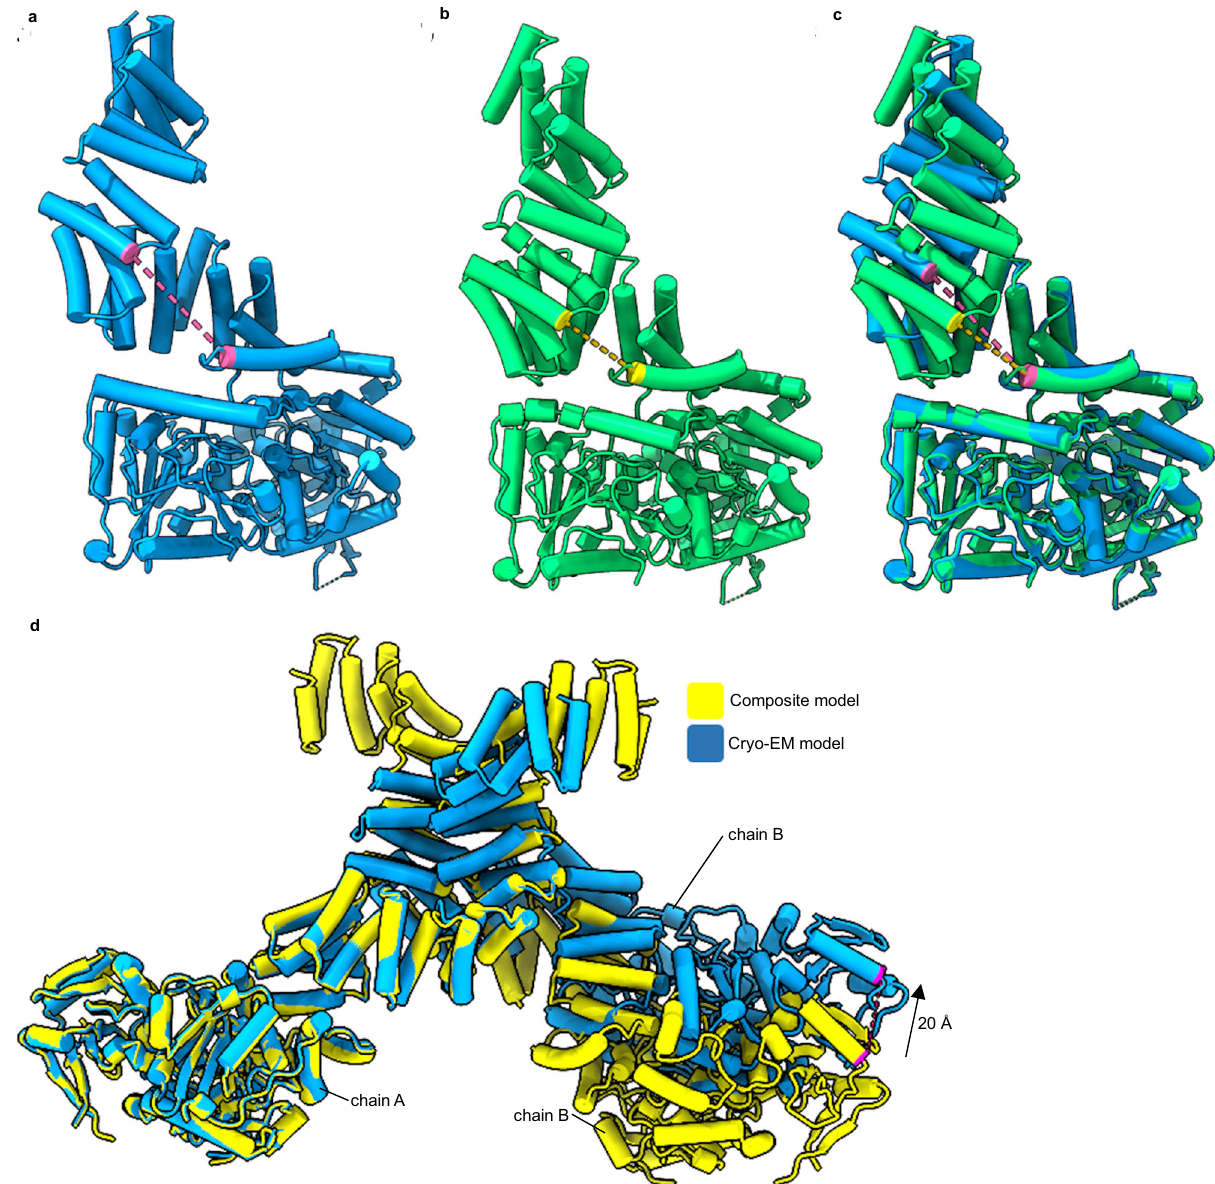
Fig. 5 Deviations from proposed full-length models of OGTs. a Cryo-EM model of OGT with the measured distance between V229 C α to E488 C α depicted as a pink dashed line. b Crystal structure composite model of OGT generated by superimposition of residues 313 – 400 of 11.5 TPR chain A (PDB: 1W3B) onto the OGT/UDP structure (PDB: 3PE3) 13, 14 . Distance between V299 C α to E488 C α depicted as a yellow dashed line, calculated as 25 Å for a and 18 Å for b . c Superimposition of residues 544 – 1028 of the Cryo-EM model onto the speculated model. A large face is opened in our structure compared to the composite structure. d Superimposition of chain A of the L254F composite model onto chain A of our cryo-EM structure 24 . Composite model was generated by superimposing our catalytic domain, with the correct TPR 10 position, onto the 11.5 TPR L254F mutant dimer crystal structure (PDB: 6EOU) using residues 260 – 360 24 . A movement of 20 Å would be required in chain B for equivalent T771 C α atoms to Expression and His-tag puri fi cation steps were as described above except only 2 l of TB was required for each mutant. Instead of dialysis, protein was diluted to 50 mM NaCl with 20 mM HEPES 7.5 and loaded onto a 5ml Q Sepharose FF column pre- equilibrated in buffer C (25 mM HEPES 7.5, 50 mM NaCl and 1 mM DTT). Protein was eluted by a stepwise gradient of buffer D (25 mM HEPES 7.5, 1M NaCl and 1mM DTT) in buffer C. Fractions containing pure protein were pooled and concentrated to 2 ml using 10,000 MWCO Vivaspin ® spin-concentrators (Sartorius), before being size excluded on a 16/60 Superdex 200 column (GE Healthcare) in 25 mM HEPES pH 7.5, 150 mM NaCl and 1mM DTT. Protein was concentrated to 3mg/ml and snap frozen. Cryo-EM sample preparation and data collection . For cryo-grid preparation, OGT was diluted in 25 mM HEPES pH 7.5, 150 mM NaCl and 1 mM DTT to 1 mg/ml and supplemented with 0.5% glycerol. The cryo-EM specimen was